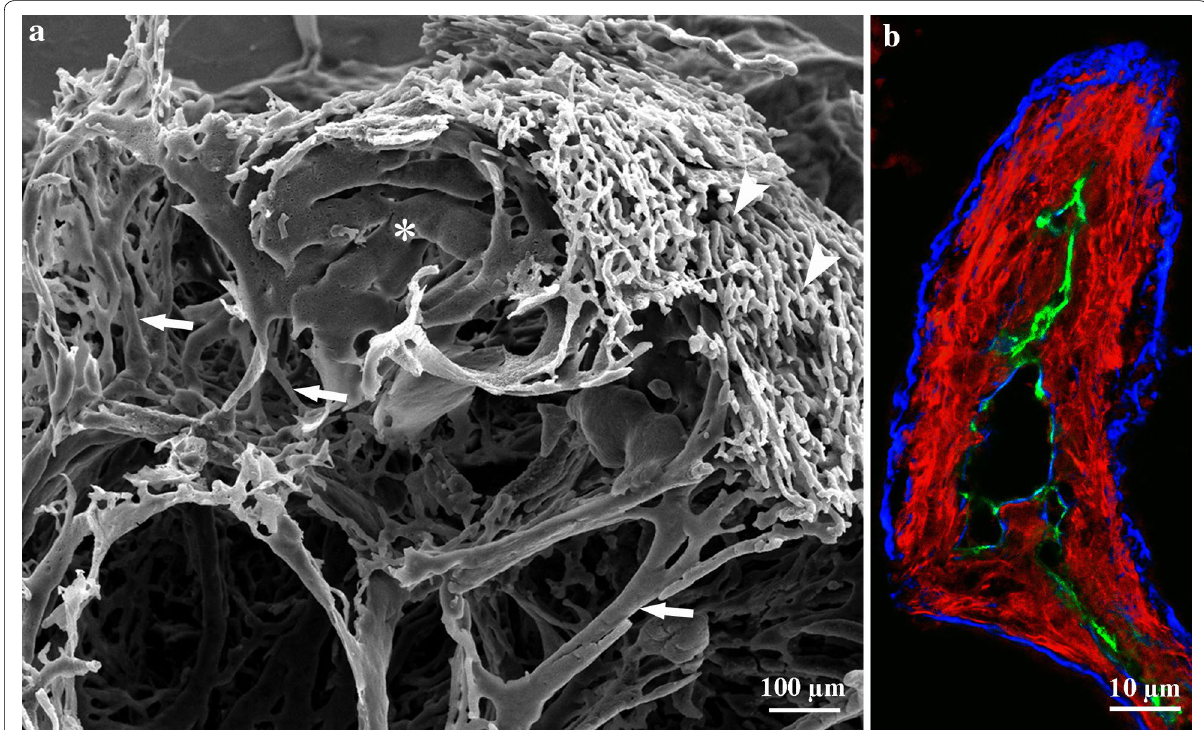
Fig. 2 Vascularization and connective tissue column formation in C38 liver metastases. a Scanning electron microscopic micrograph of the vas‑ culature of an experimental colorectal carcinoma metastasis in the liver after corrosion casting. On the upper-right side can normal structure of the sinusoidal system be observed ( arrowheads ). Sinusoidal lakes ( asterisk ) developed by fusion of the sinusoids can be observed close to the surface of the tumor. Arrows point at vessels supplying the metastasis. These structures correspond to the structure labeled by CD31 on Fig. 2b. Scale bar 100 µm. b The structure of (blood supply‑providing) connective tissue columns in liver metastases. CD31‑positive vessel ( green ) is located centrally and surrounded by smooth muscle actin ( red )‑expressing cells. The structure is surrounded by basement membrane (laminin, blue ) deposited by tumor cells. Basement membrane (laminin, blue ) of the central vessel can also be observed. Tumor cells (not stained) are located in the black